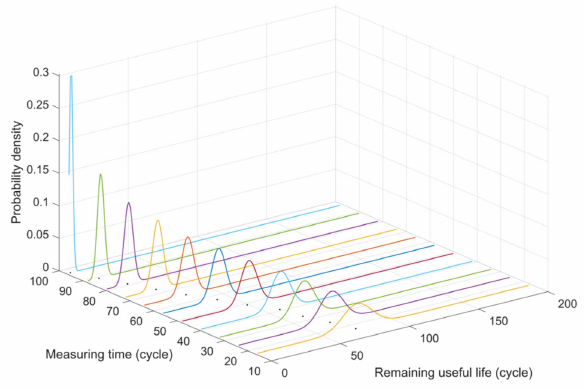
Figure 5. PDF of RUL with simulation